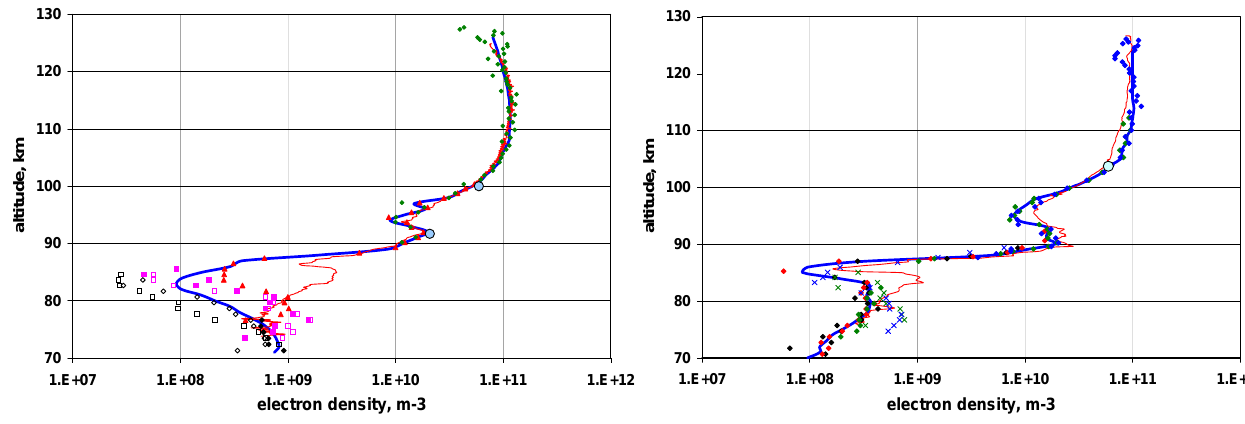
Fig. 1. Plasma densities measured by sounding rockets MASS-1 (left, 3 August 2007, 22:51UT) and ECOMA-3 (right, same day, 23:22UT). Bold blue lines represent the final electron densities in best agreement with the raw data (symbols), the fine red lines are ion densities normalised in the E-region to the wave propagation electron densities.